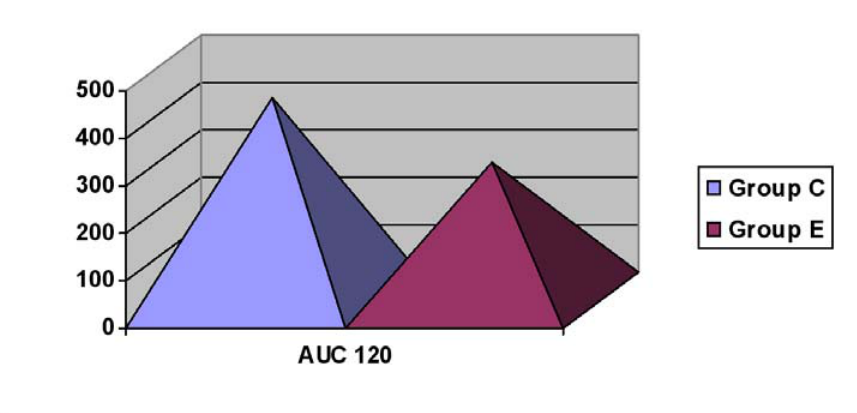
Fig. 1 The area under the paracetamol concentration curve from 0 to 120 min (AUC 120 ) in the control group C and E group (early postoperative gastric supply of nutritients) [p =